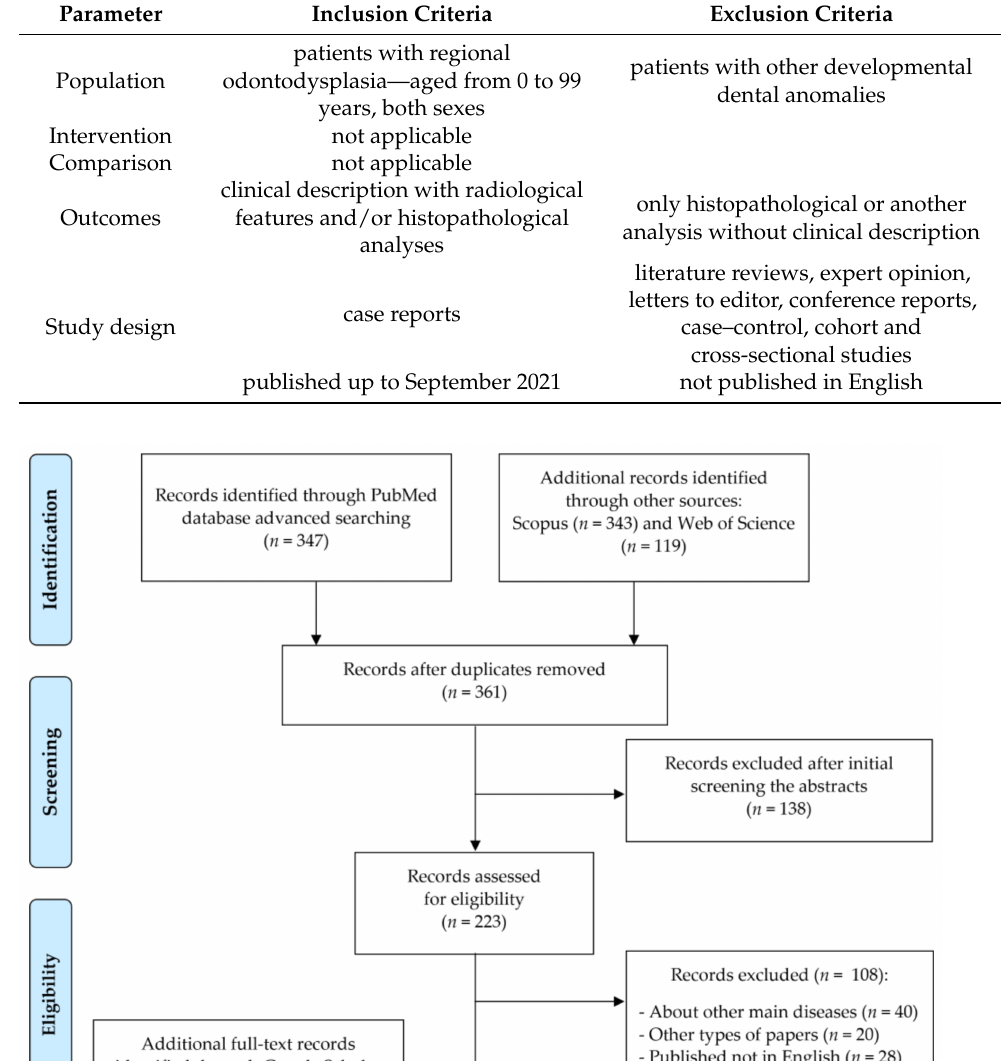
Table 1. Inclusion and exclusion criteria according to the PICOS.